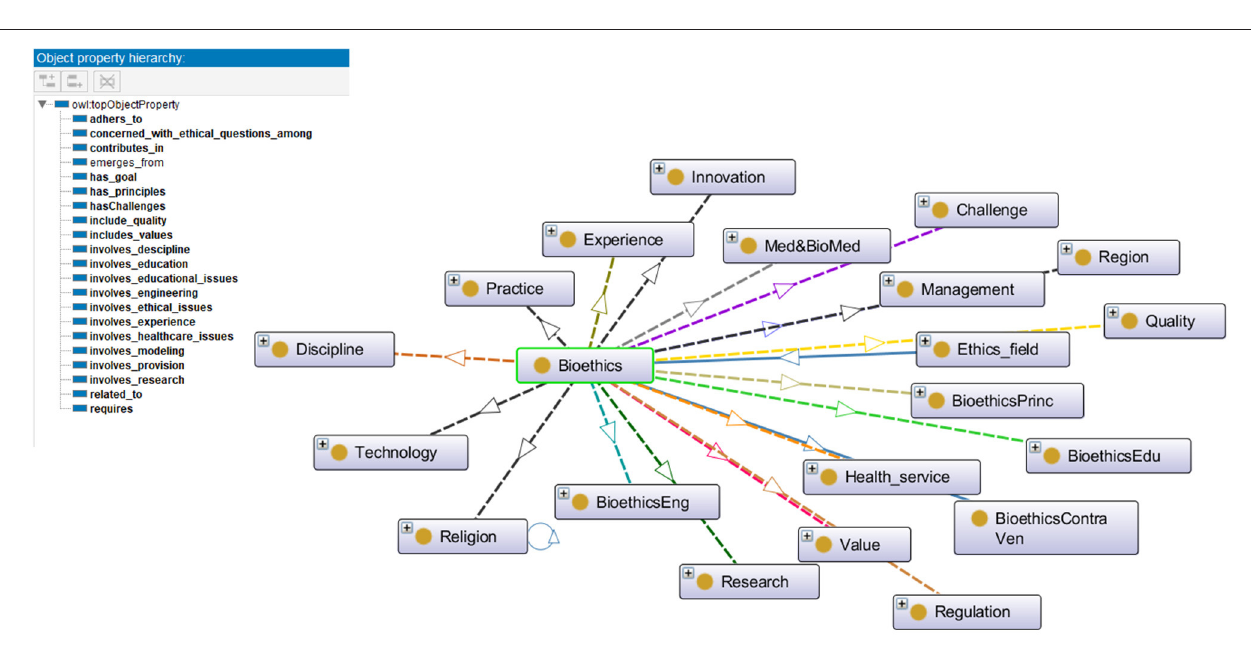
FIGURE 3 | The properties for the Bioethics object, and the relationships between "Bioethics" class and other classes in the iOntoBioethics